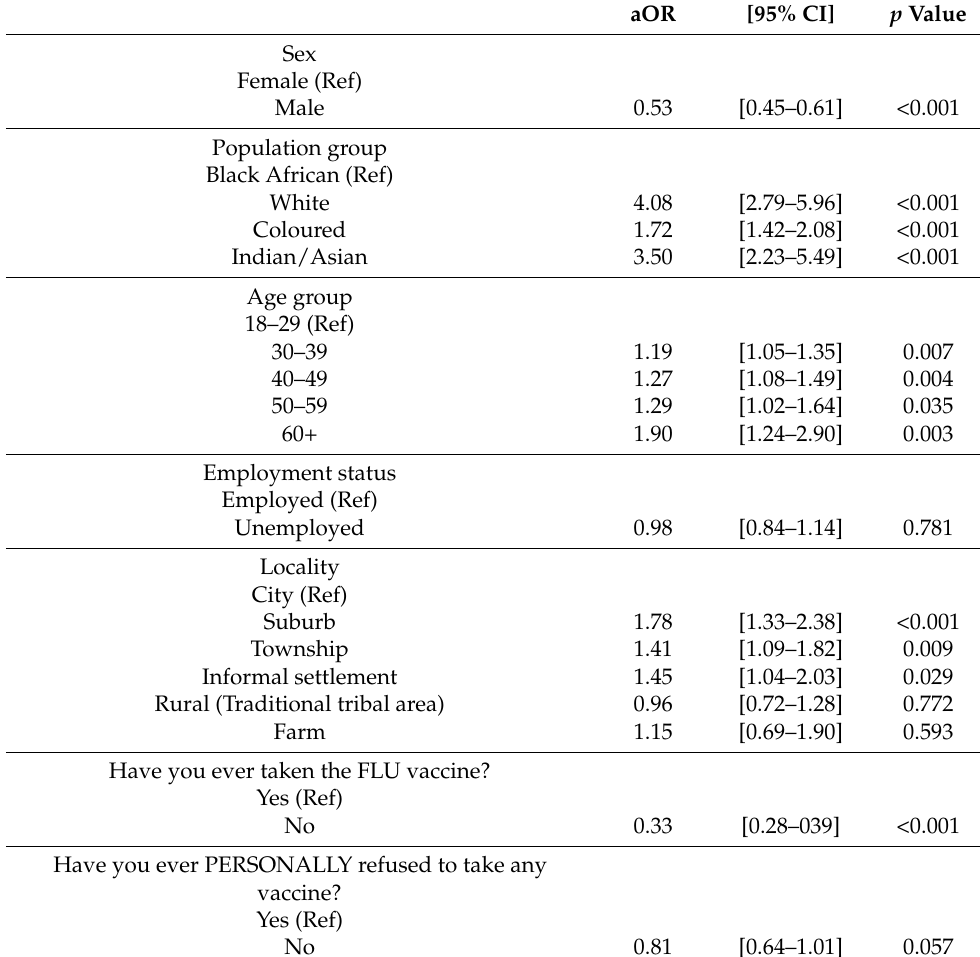
Table 4. Multivariate logistic regression of factors that influence parents’ having taken their children for scheduled